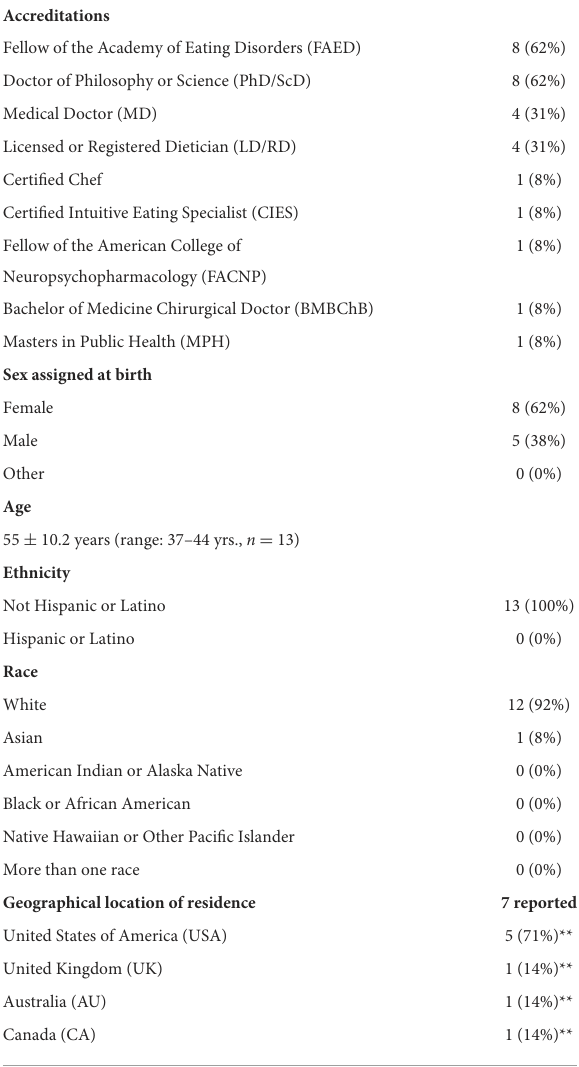
TABLE 3 Characteristics of the 13/14 study participants who provided demographic